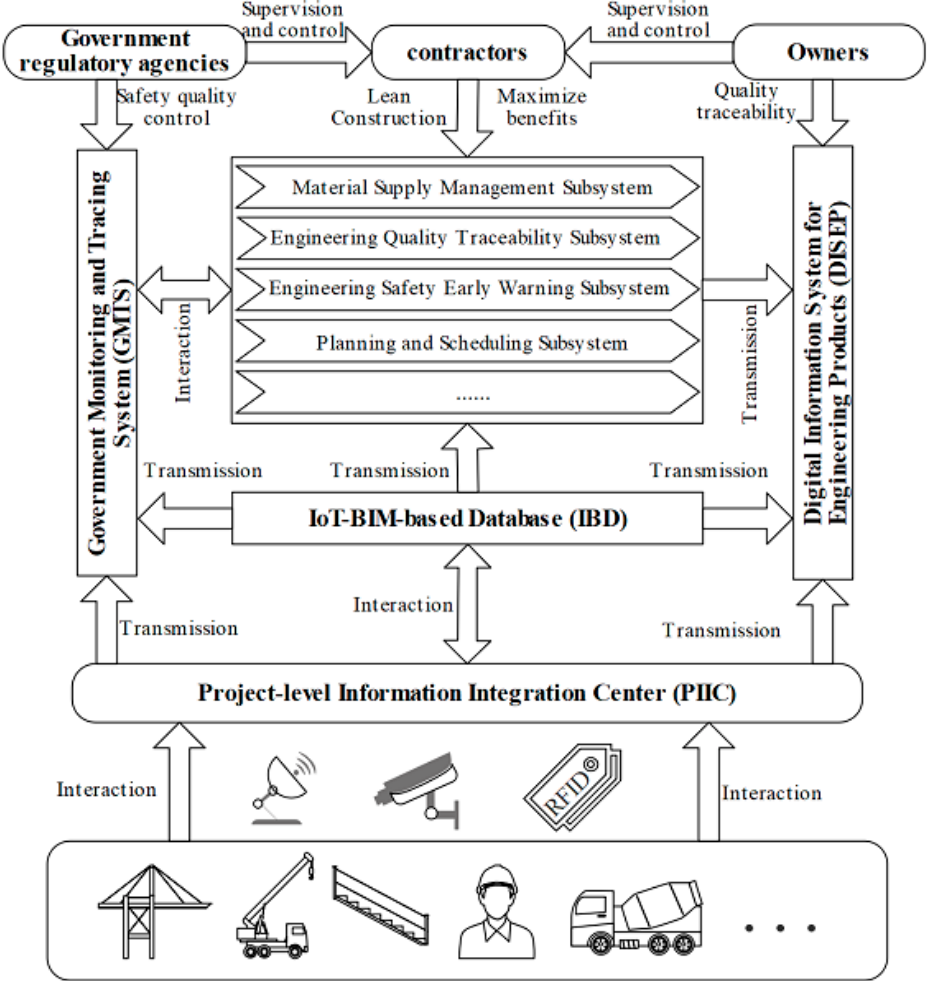
Figure 1. Conceptual framework of Intelligent Construction System for Prefabricated Buildings